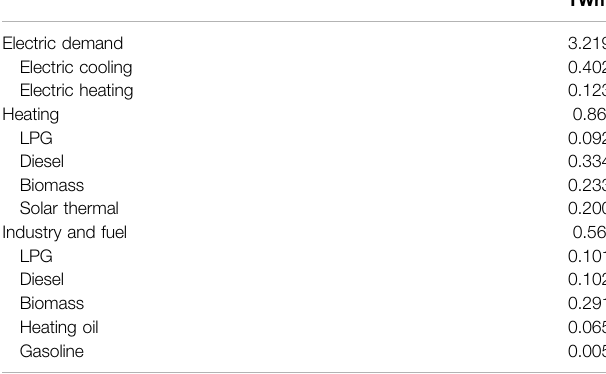
TABLE 2 | Annual energy consumption by the type of fuel.